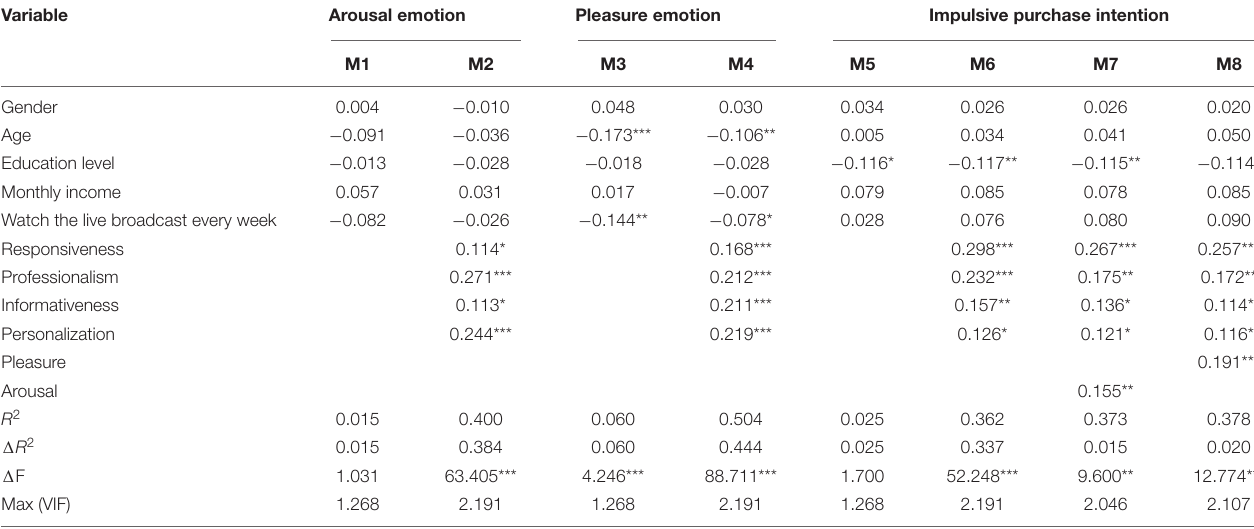
TABLE 4 | Main and intermediary effect test results.